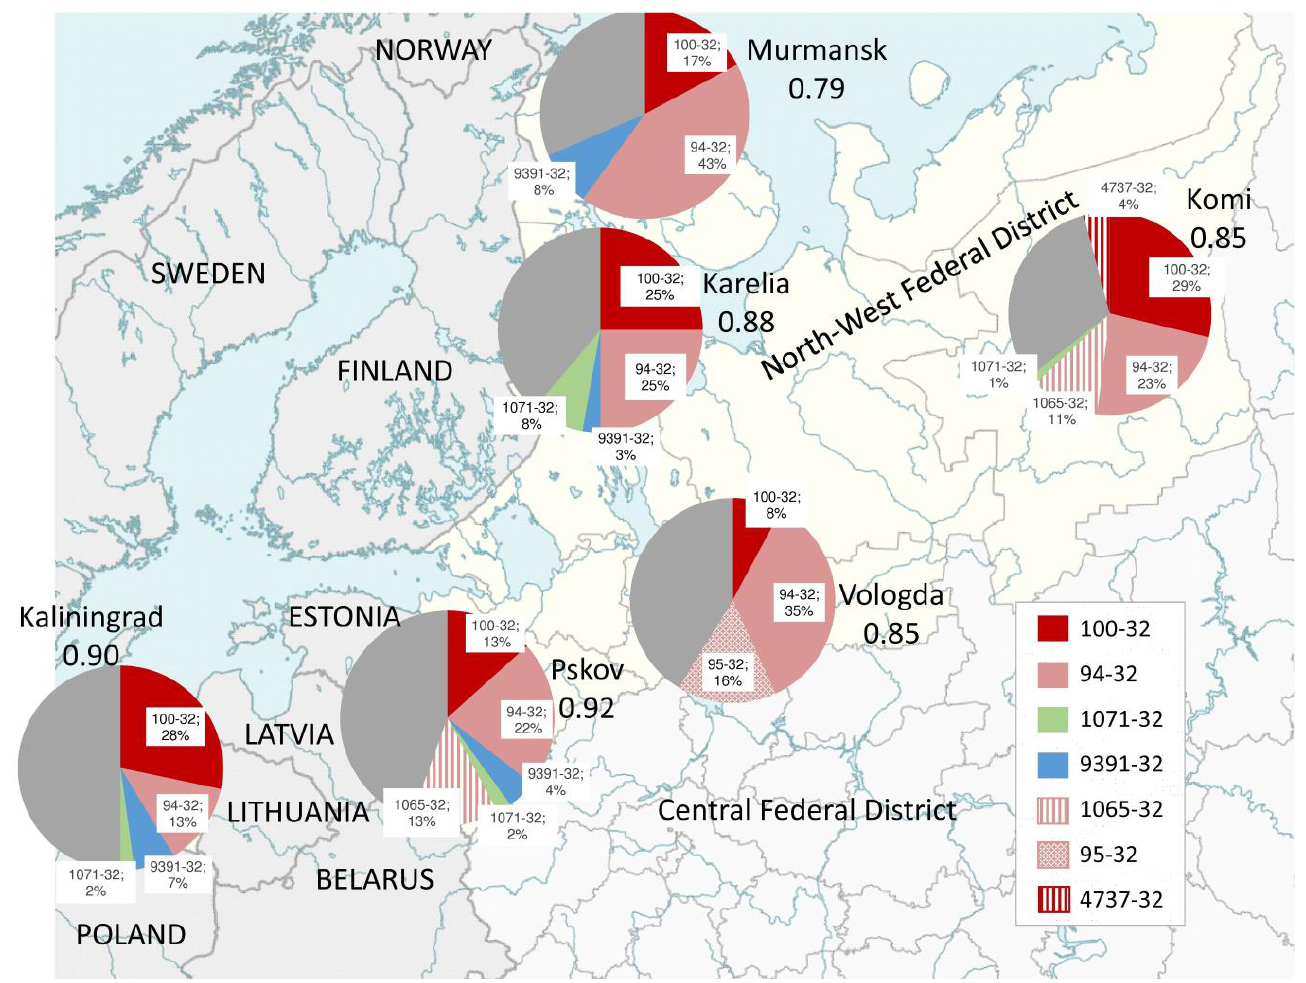
Figure 2. Geographic distribution of the Beijing VNTR types in six provinces in Northwestern Russia. HGI values are shown below the regions’ names. Free map: https://commons.wikimedia.org/wiki/File:Outline_Map_of_Northwestern_Federal_District.svg (accessed on 1 December 2022). Table 4. Regional VNTR-based diversity of M. tuberculosis Beijing genotype strains.